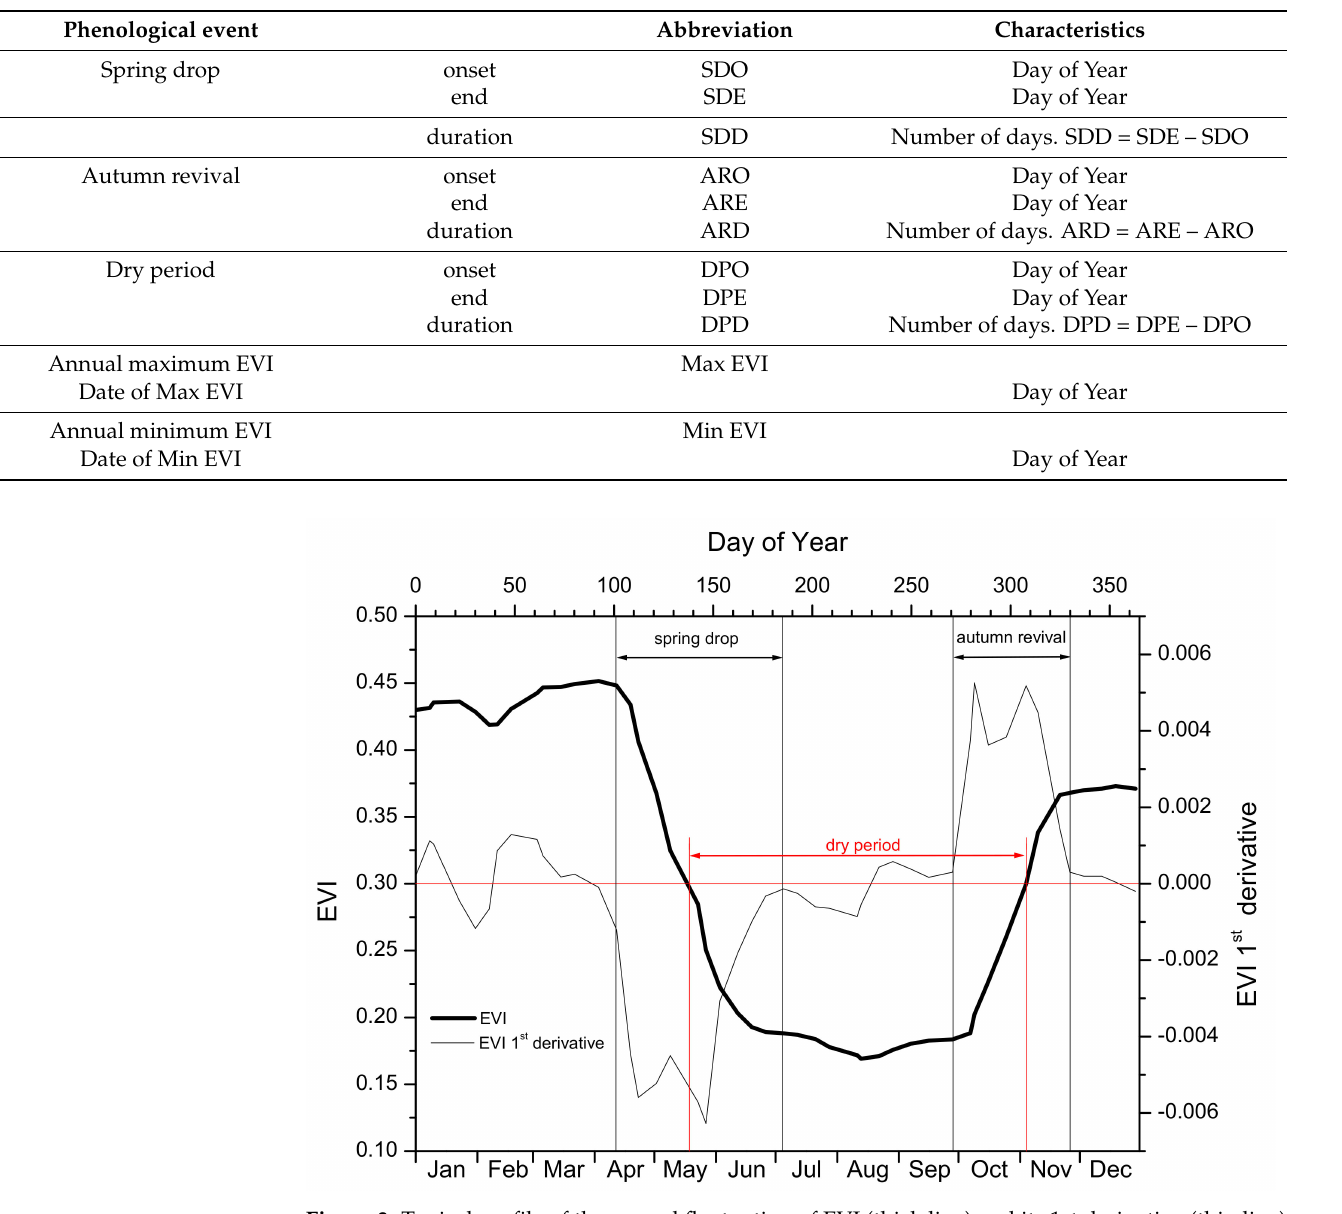
Figure 3. Typical profile of the annual fluctuation of EVI (thick line) and its 1st derivative (thin line). Red horizontal line corresponds to EVI = 0.3 and EVI 1st derivative = 0. Black vertical lines indicate the onset and end of the spring drop and the autumn revival period, when EVI 1st derivative departs or returns to zero values for onset and end correspondingly. Red vertical lines indicate the onset and end of the dry period, when EVI is lower than